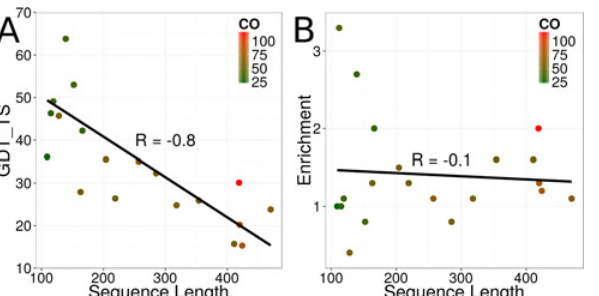
Fig 2. Sampling accuracy and model discrimination for the protein targets. (A) GDT_TS value of the most accurate model for each of the twenty regular targets sampled by the low-resolution topology search in dependence of the protein ’ s sequence length. The coloring is according to the complexity of the protein ’ s fold as quantified through the contact order metric (CO). (B) Model discrimination for each of the twenty regular targets as quantified through the enrichment metric in dependence of the protein ’ s sequence length. The coloring is according to the complexity of the protein ’ s fold quantified through the contact order metric